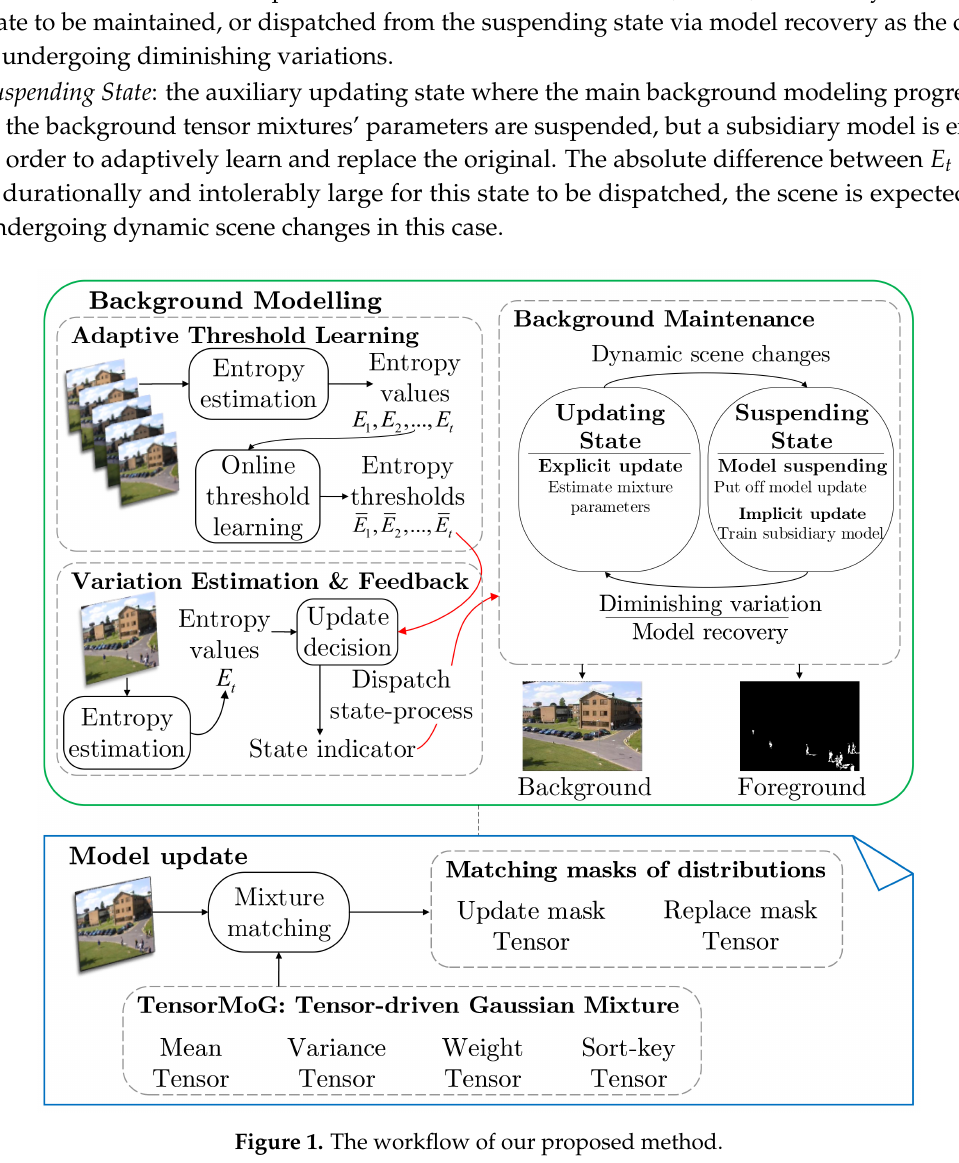
Figure 1. The workflow of our proposed